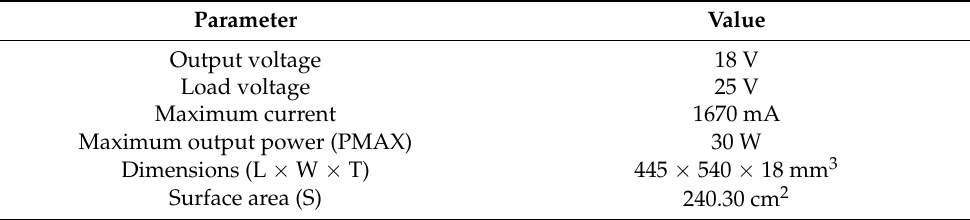
Table 6. Features of the adopted solar cell.